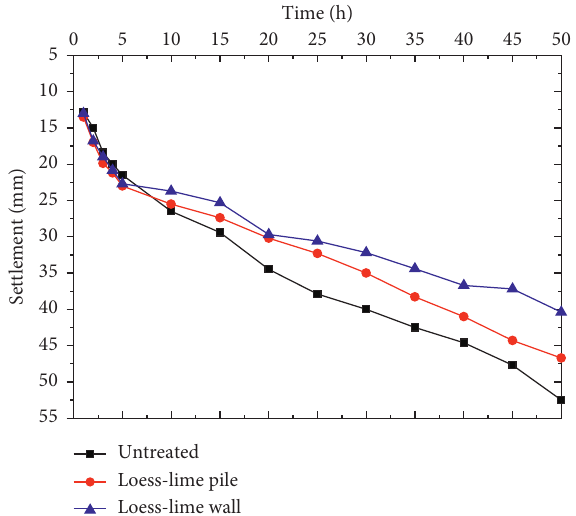
Figure 6: Subgrade settlement changes with